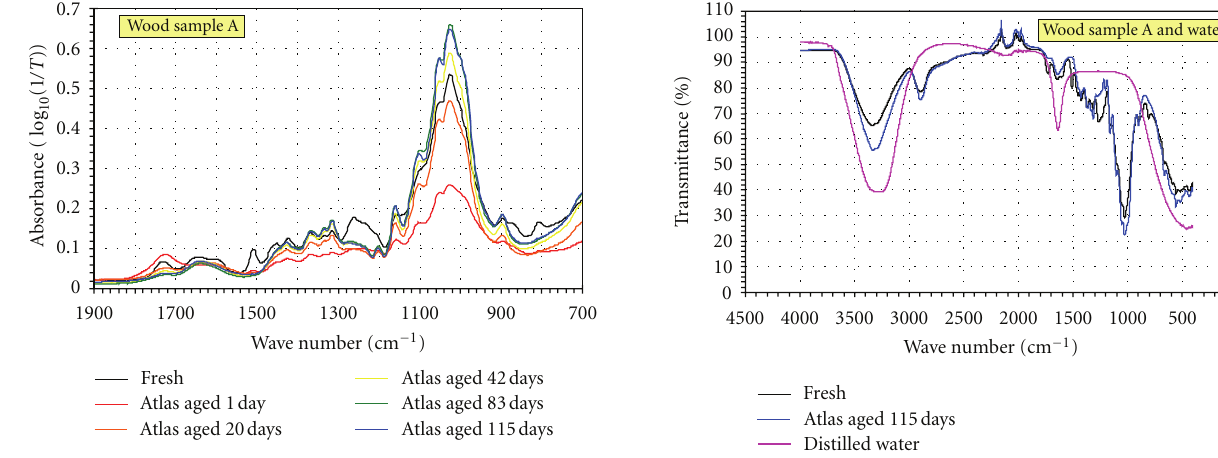
Figure 7: Transmittance versus wave number between 4000– 400 cm − 1 for wood sample A during accelerated ageing (fresh and 115 days, see Figure 3 for more details) in an Atlas Solar Simulator including a comparison with the distilled water